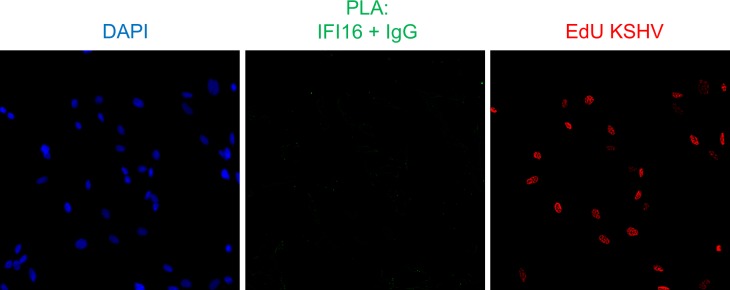
Uncropped source PLA data for Figure 5C (continued).A larger field containing multiple cells are shown.